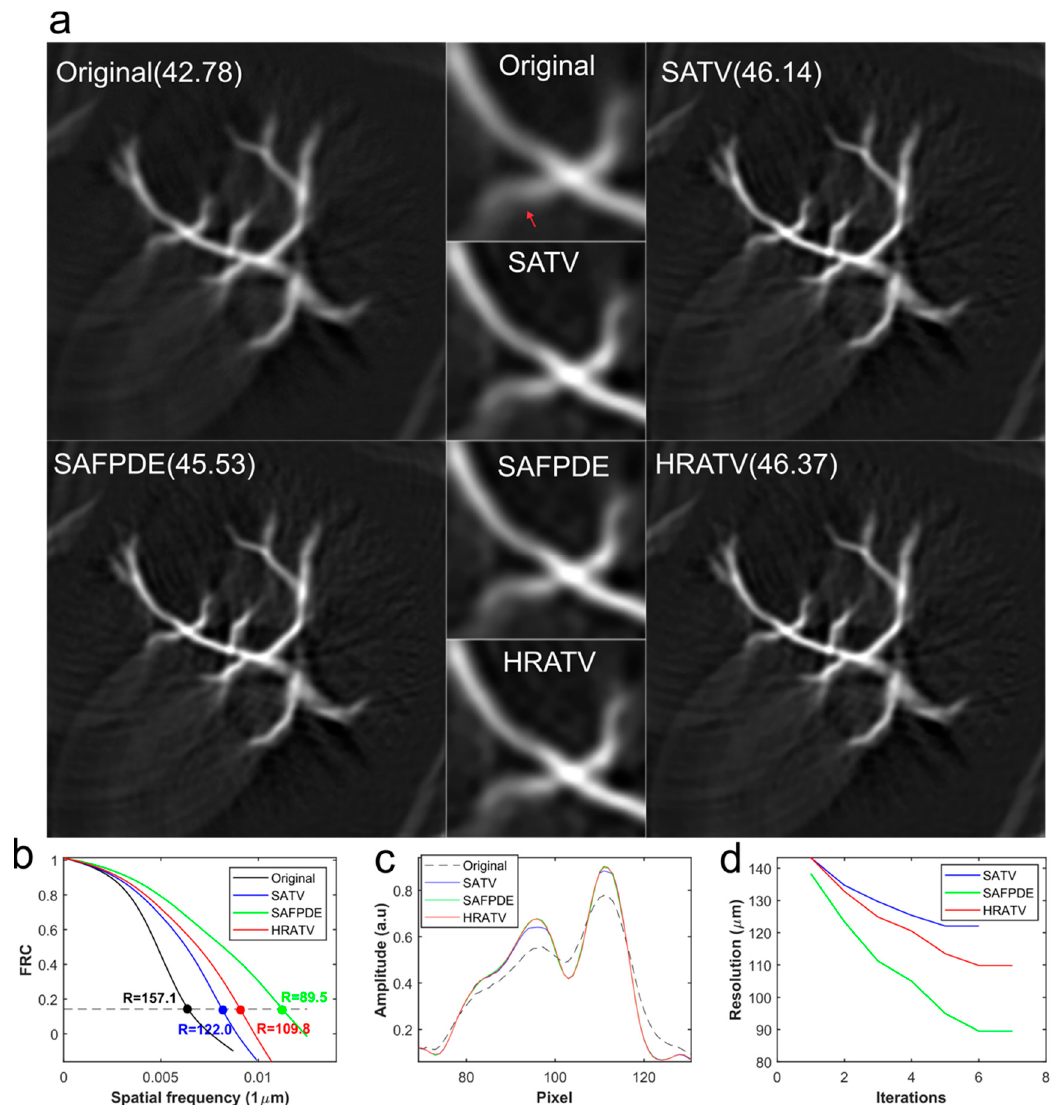
Figure 6. Deconvolution results of simulated blood vessel phantom. ( a ) Original image and images after deconvolutions. The vessel indicated by the red arrow is selected to calculate the SNR and the results are shown beside the image titles. ( b ) FRC measurements of the original image and the images after deconvolutions. ( c ) Line profiles of the vessels indicated by the red arrow. ( d ) Estimated resolution during iterations.